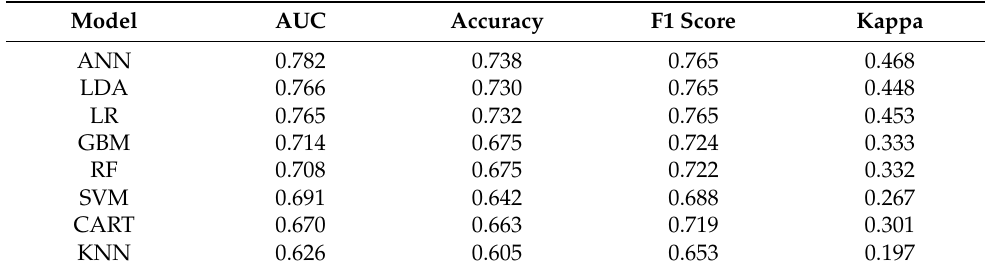
Table 4. Model’s AUC, accuracy, F1 score, and kappa